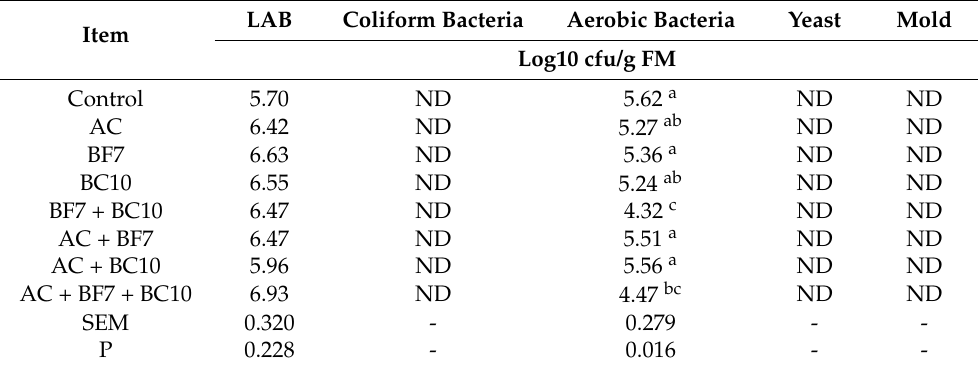
Table 4. Microbial population of cassava root silage prepared with additives measured after 30 days of ensiling. LAB Coliform Bacteria Aerobic Bacteria Item